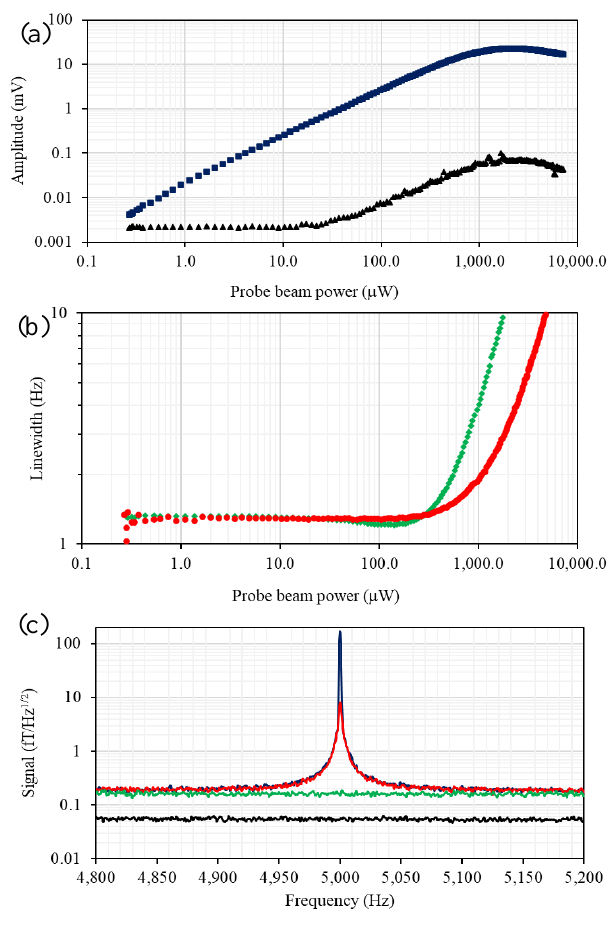
Figure 4. ( a ) The amplitude and linewidth (red dots) of the rf spectral profile as a function of pump beam power recorded at cell temperature of 22 ◦ C. of the magnetometer signal versus the probe-beam power (blue squares). The sum of the various noise components (electronic noise, photonic-shot noise, atomic-projection noise and probe-beam back-action) is depicted by the black triangles. ( b ) The linewidth of the magnetometer signal as a function of probe beam power recorded at two probe laser detunings, 0.972GHz (red dots) and 0.486GHz (green diamonds). ( c ) Frequency spectrum of the radio-frequency magnetometer recorded with (blue solid line) and without (red dashed line) calibrated rf magnetic field. The photonic-shot-noise level represented by the green line and the black line describes the baseline electronic noise. The resolution bandwidth for the measurement was 1Hz, pump beam power was 750µW, probe beam power was 200µW, and the atomic density was 3.3 × 10 10 cm − 3